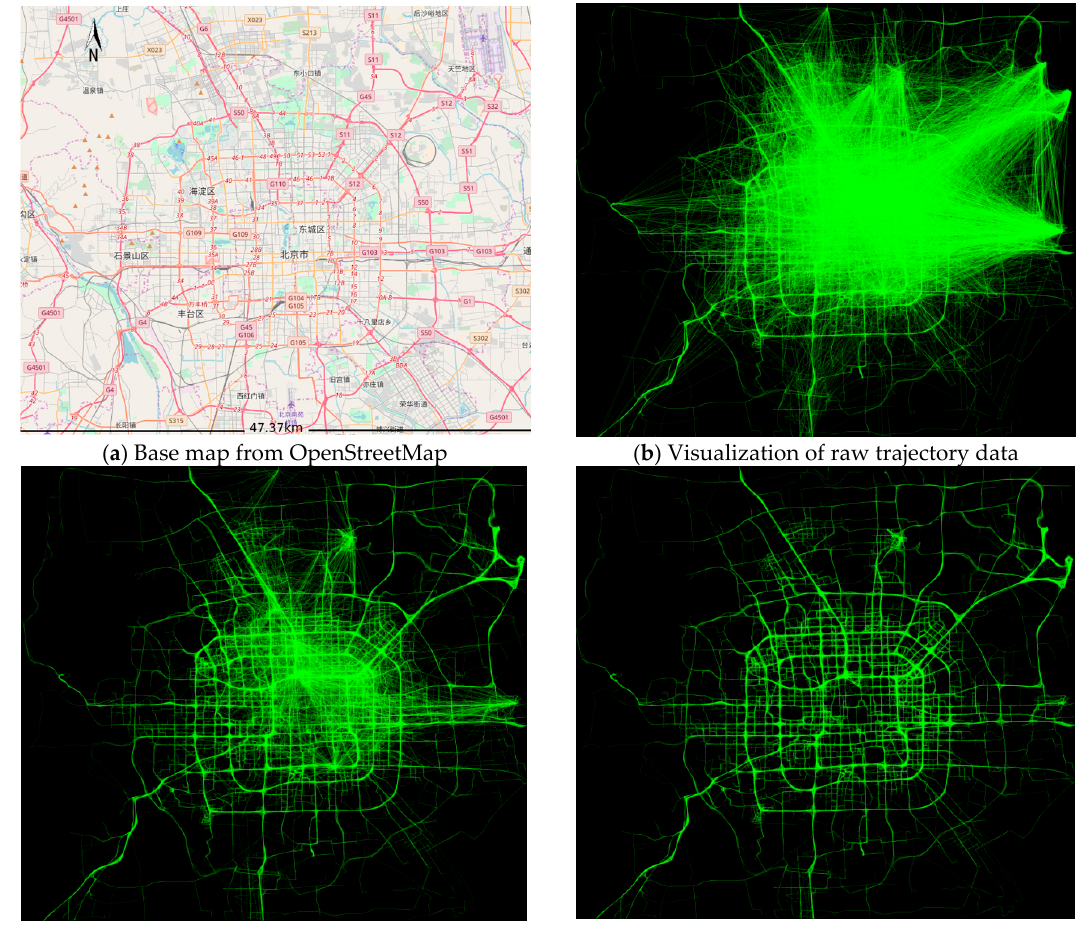
Figure 6. Base map and snapshots for the preprocessing trajectory data from Beijing. ( a ) A base map from OpenStreetMap. ( b ) A visualization of 5.76 million raw trajectory data points using OpenCV. ( c ) A visualization of those trajectory data after time filter 0 s < Δ t < 600 s. ( d ) A visualization of the trajectory data after preprocessing. As shown in the picture, our preprocessing algorithm can effectually remove noise. Table 3. Statistics of the resulting digital